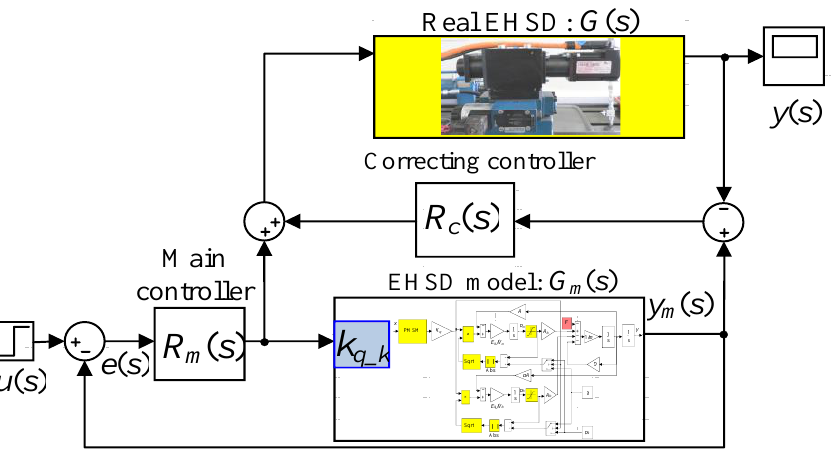
Figure 1. Model-following control block scheme.